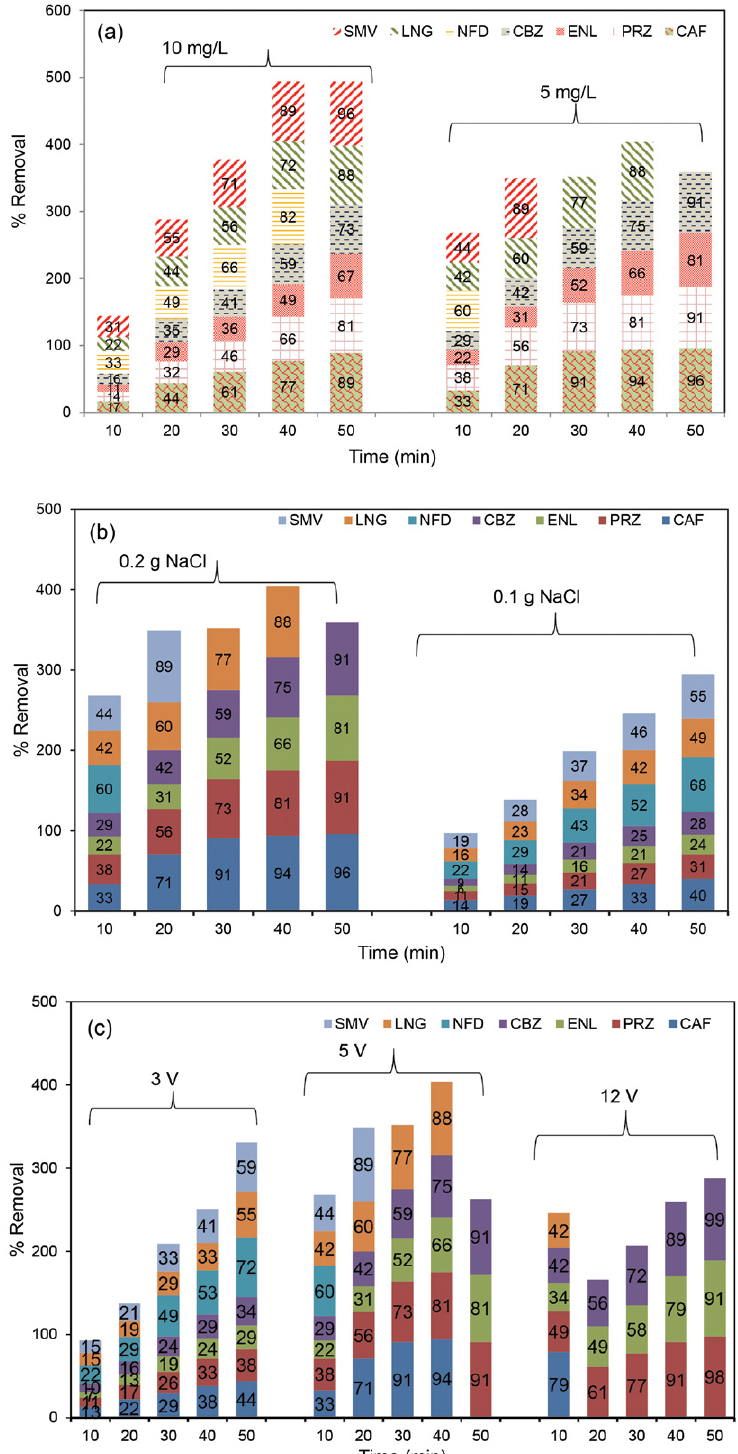
Figure 3.% Removal for all studied pharmaceuticals: (a) effect of initial concentration at 5 V and 2 g/L NaCl, (b) effect of NaCl amount at 5 V and 5 mg/L and (c) effect of applied voltage at 5 mg/L and 2 g/L